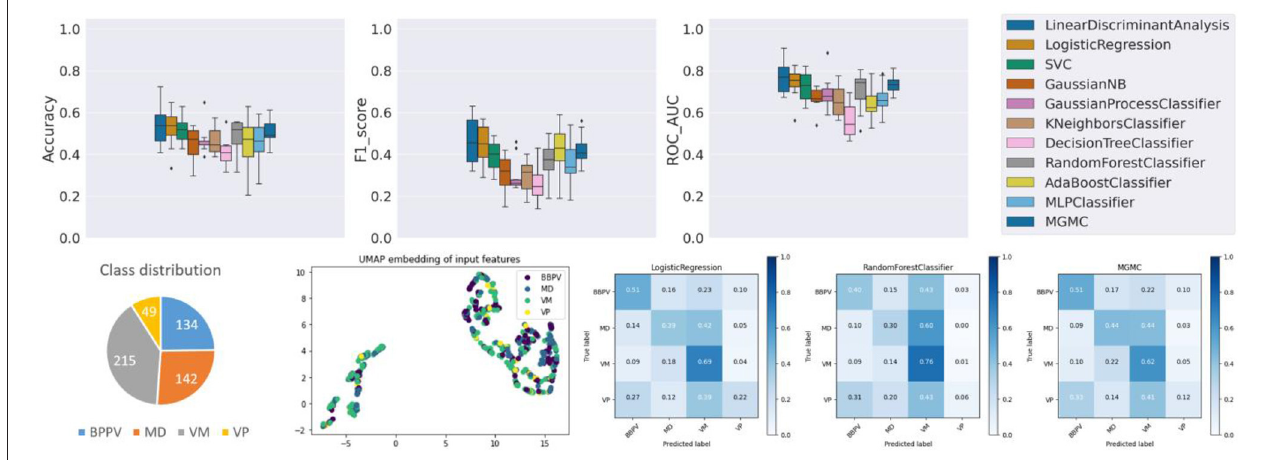
FIGURE 4 | Results panel produced by base-ml for Task